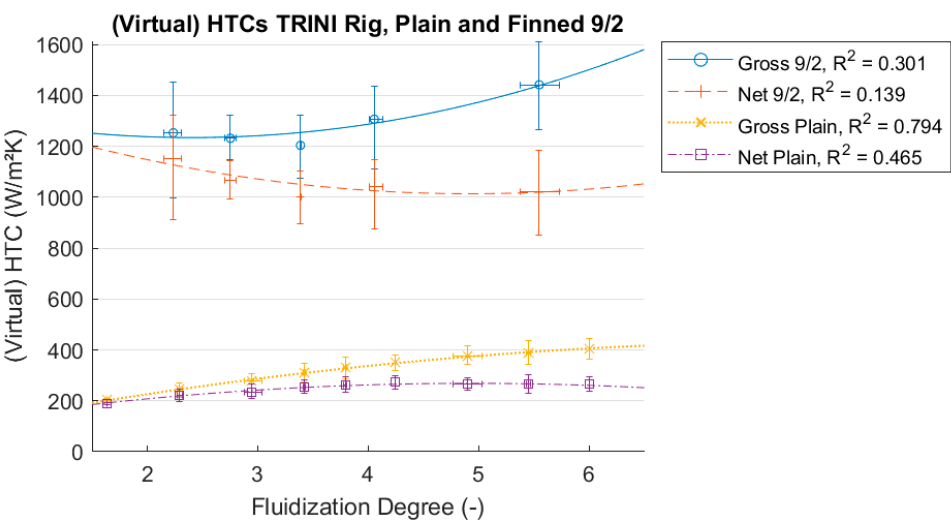
Figure 19. Comparison between plain and helically finned tubes, pitch 9 mm, thickness 2 mm, TRINI test rig, 146 µm particles.